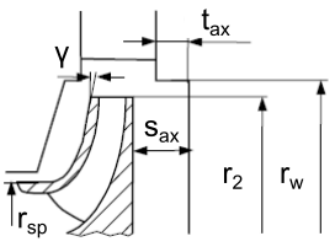
Figure 15. Designation of the variables for real impeller geometry